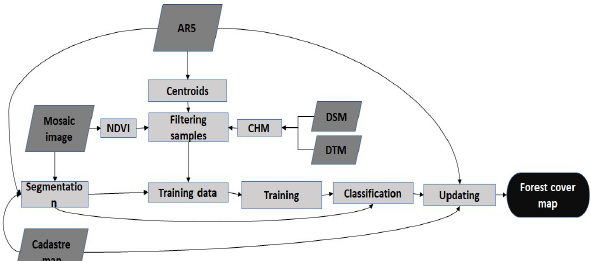
Figure 2. Workflow diagram of the overall automated